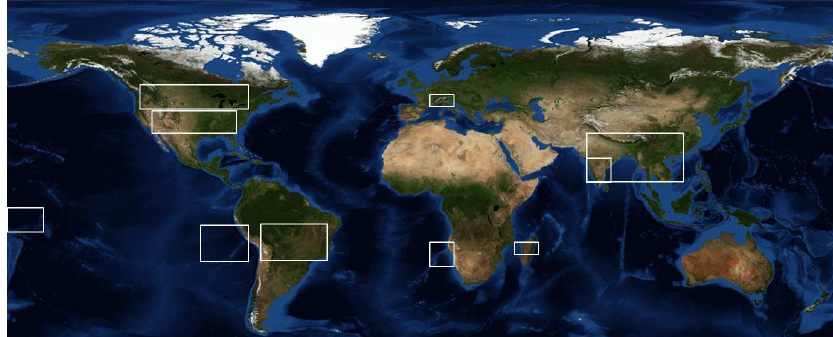
Fig. 18. Rectangular boxes represent interesting locations of selected sites for estimating LER trends based on the latitude × longitude trend maps shown in Fig. 11. The map is based on the Suomi National Polar-orbiting Partnership (SNPP) Visible Infrared Imaging Radiometer Suite